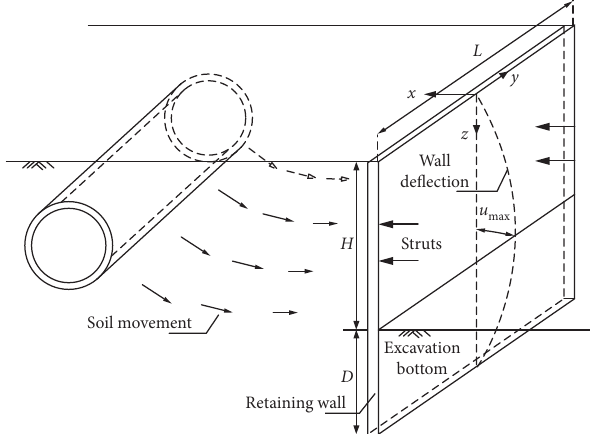
Figure 1: Schematics showing the influence of deep excavations on adjacent